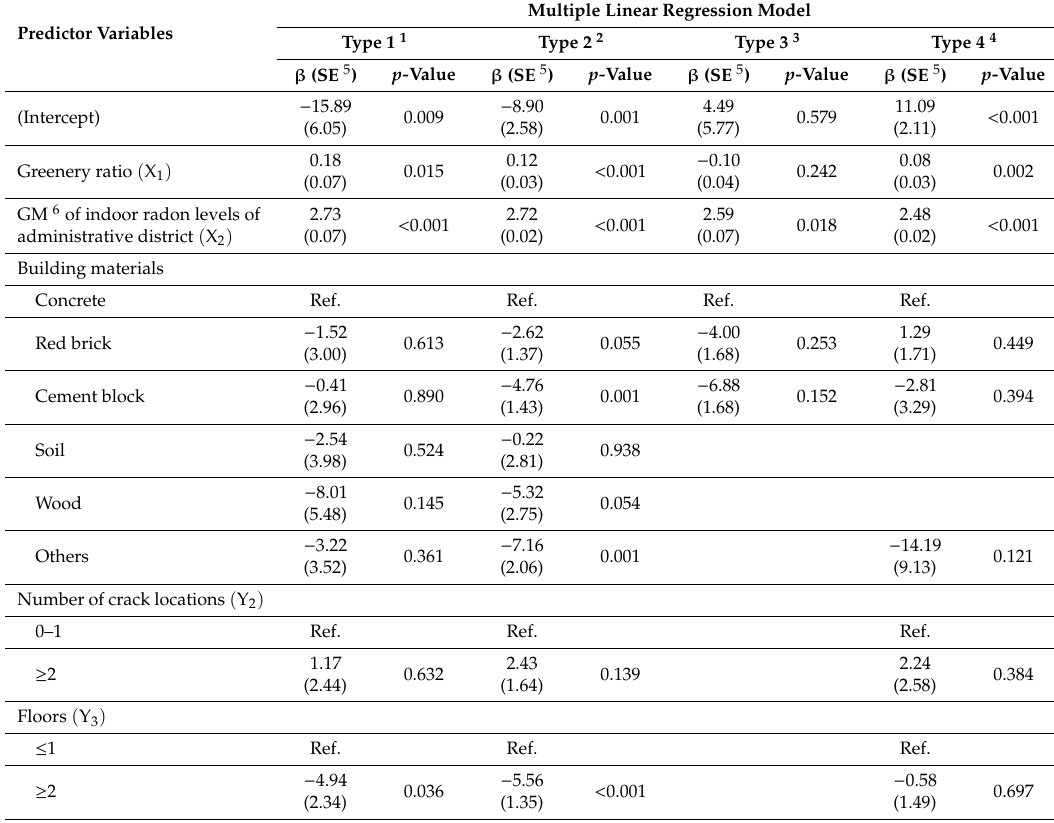
Table2. Estimatesofthecoe ffi cientsoftheinfiltrationfactormodelaccordingtoresidencecharacteristics. Predictor